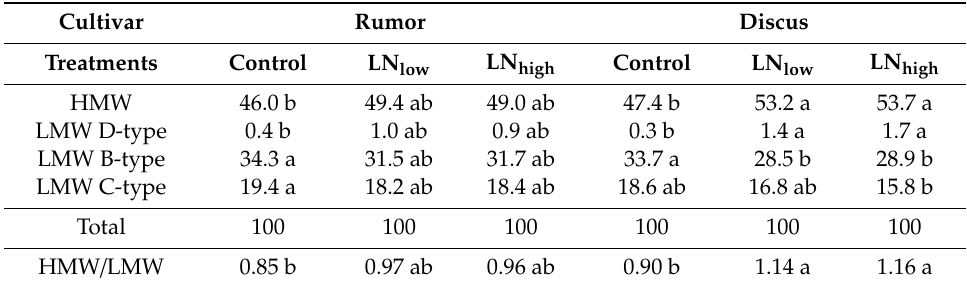
Table 6. Relative distribution of the glutenin subunits (% of total glutenins) in response to late N application (Control, LN low , LN high ) for the two cultivars Rumor and Discus. Cultivar Rumor Discus Treatments Control LN low LN